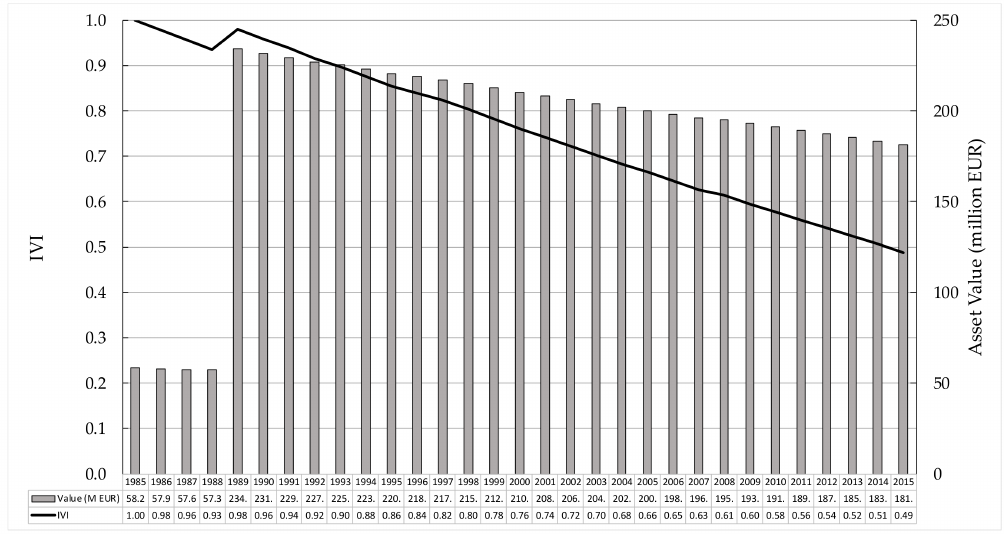
Figure 7. Operational Sub-system 1. IVI and Asset